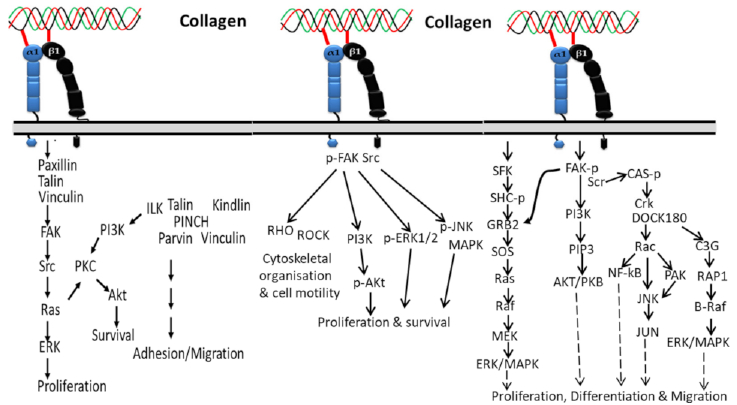
Figure 1. Collagen integrin signals in the normal physiological function of